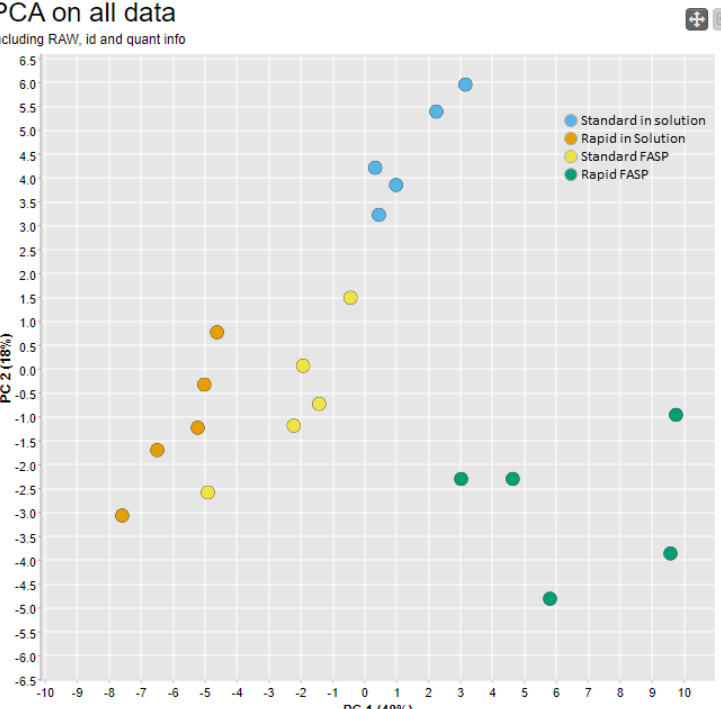
Figure 7. PCA analysis of the raw and identification data features. CSF samples were digested using different approaches with five replicates each for standard in-solution digestion (blue), rapid in-solution digestion (orange), standard FASP (yellow), and rapid FASP (green). Using MaCProQC, PCA based on all data (raw, identifications, and quantifications) was carried out in order to visualize inter- and intragroup variability for all four datasets. FASP clustered the worst, pointing to the lowest